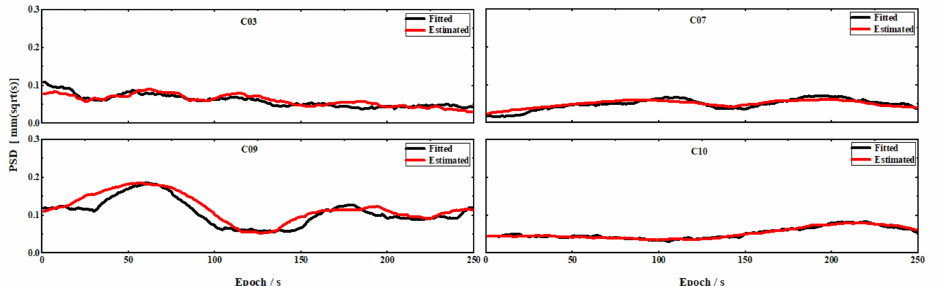
Figure 3. The PSD obtained by the moving average approach and the PSD obtained by the linear fitting approach for satellite C03, C07, C09 and C10.